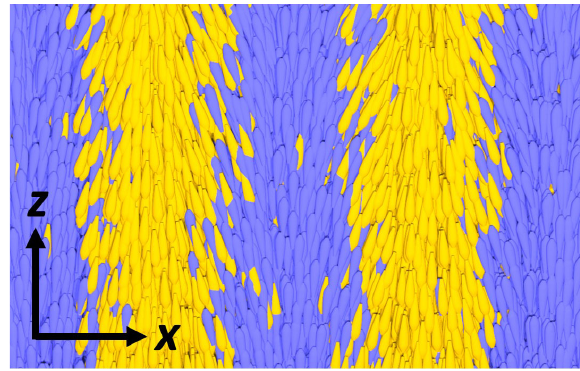
FIG. 11. Schematic of the proposed splay phase, where different colors denote orientation of the molecules either along n or − n